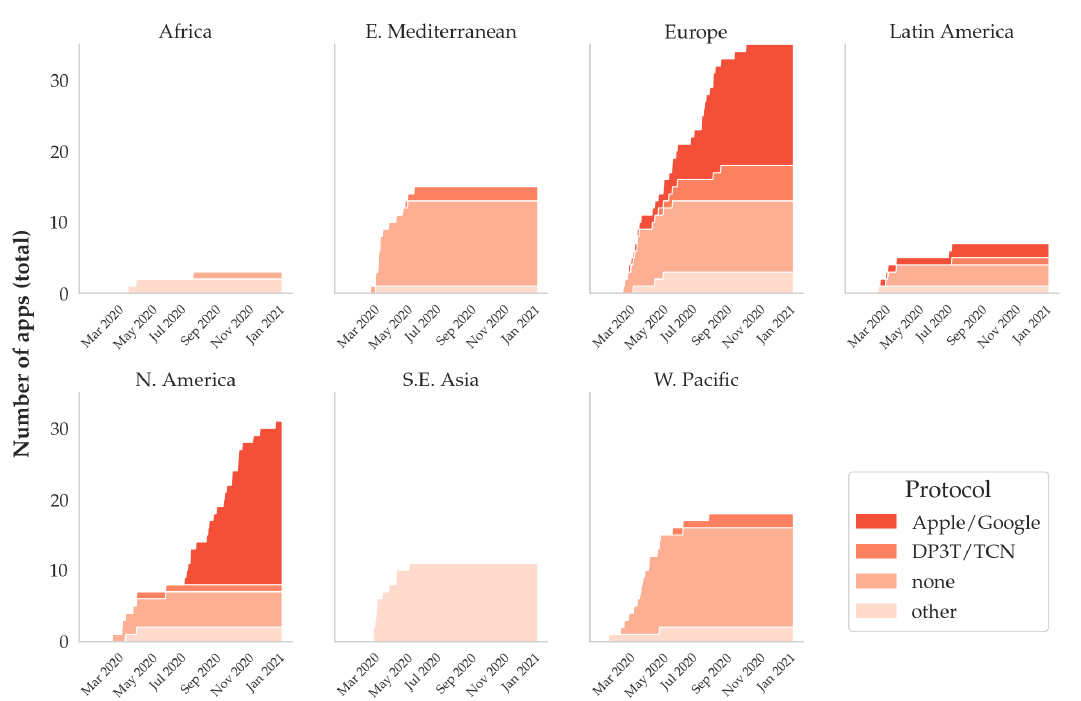
Figure 4. Cumulative number of released contact tracing apps implementing different protocols, disaggregated by WHO region. The total area of each subplot represents the total number of apps released in each